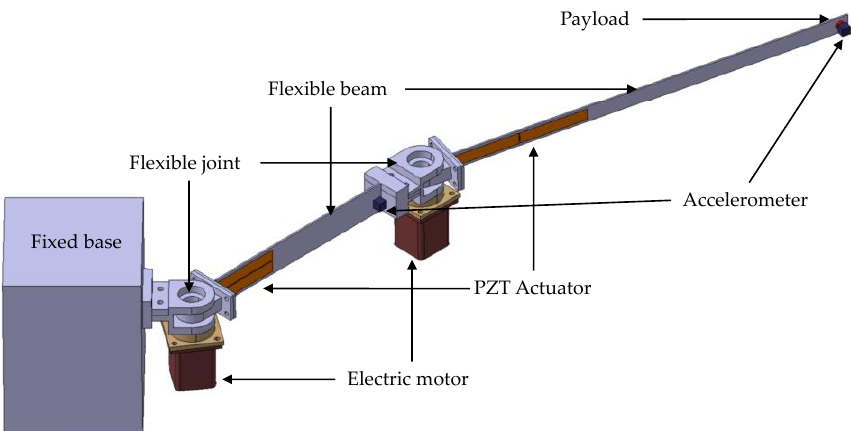
Figure 11. Two-link flexible manipulator with fixed base. Table 3. Kinematic and dynamic parameters of the space manipulator system.